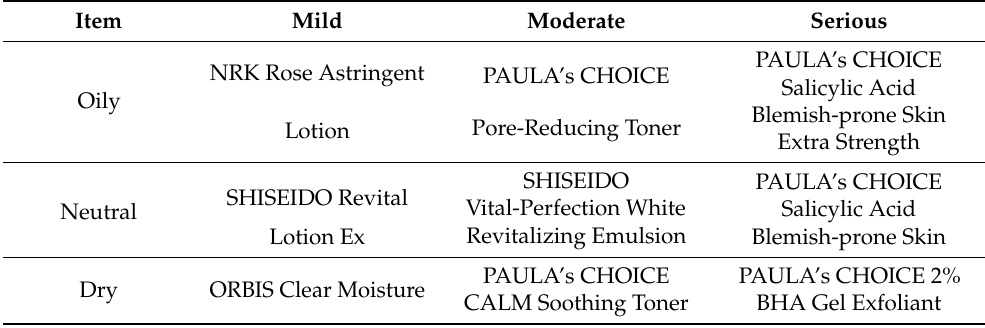
Table 3. List of skin care products.